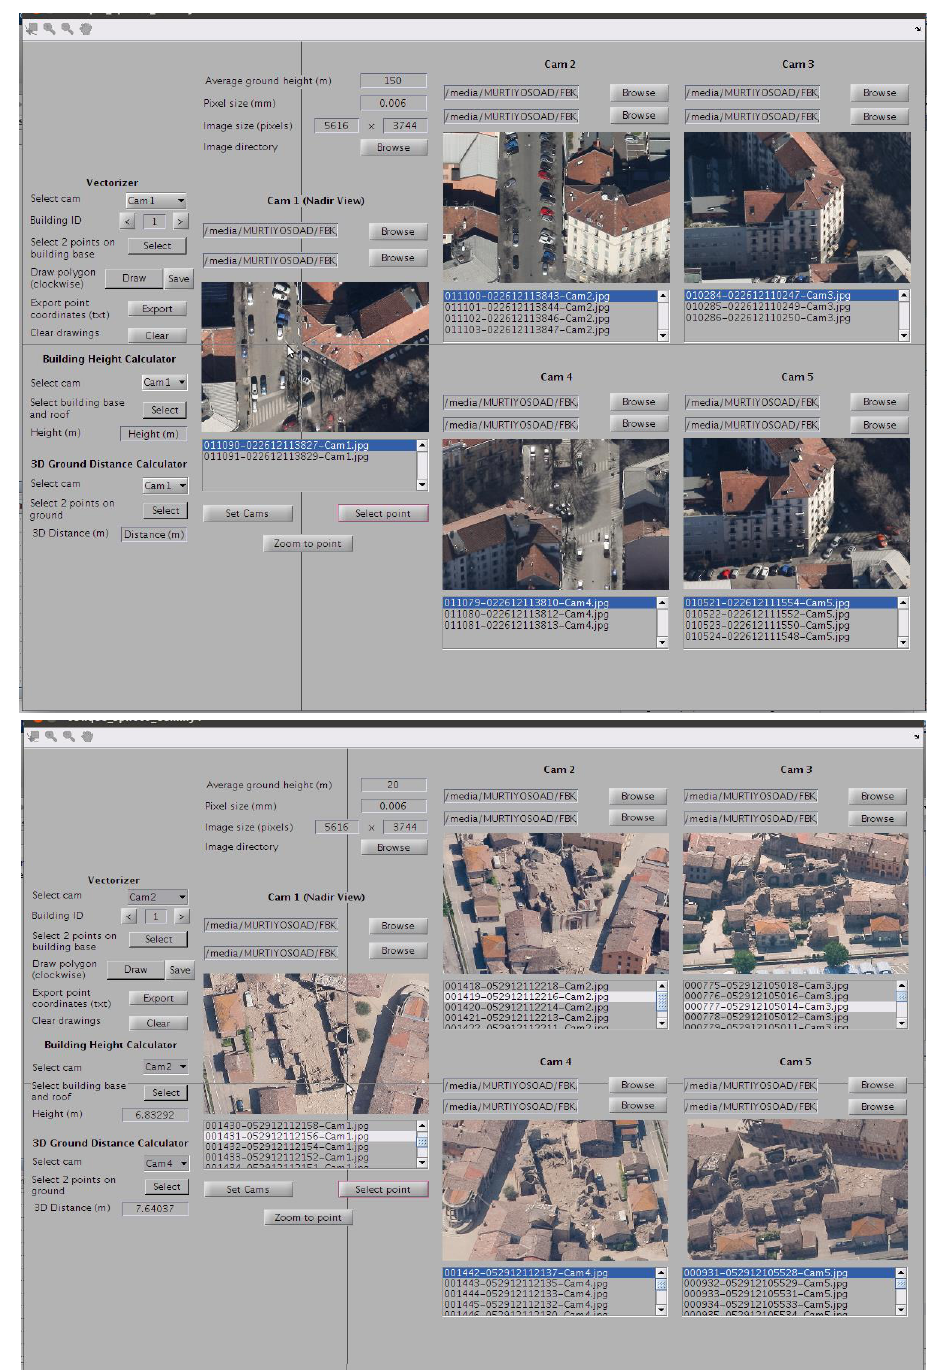
Figure 3: Use of photogrammetric functions to inspect buildings from oblique imagery. Examples from Midas5 / BlomOblique multi-camera system: Milano dataset (above) and San Felice sul Panaro dataset